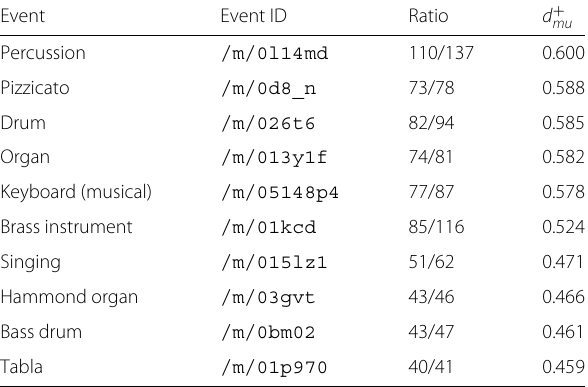
Table 13 Top 10 positive distractor events for music (event labels related to false positive decisions of the network about the “music”